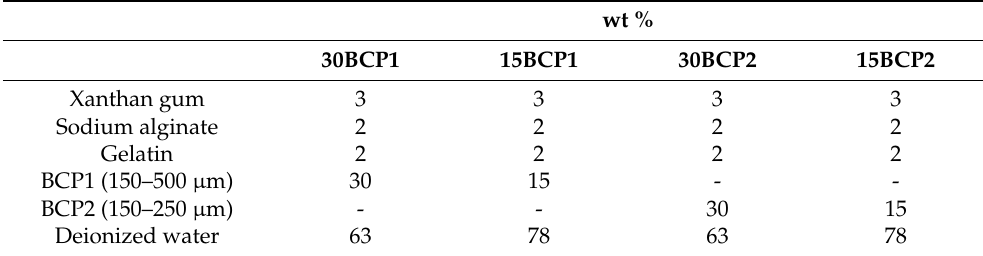
Table 3. Biomaterial ink